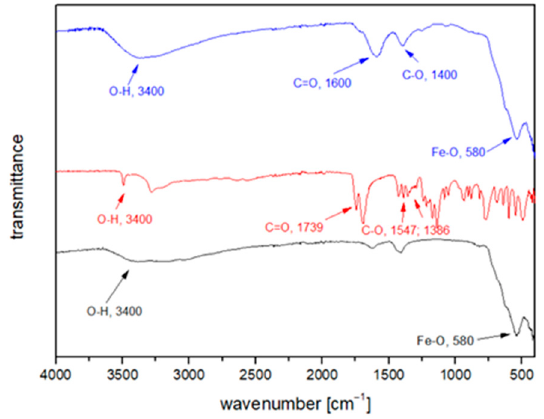
Figure 2. FTIR spectra of magnetite MNPs (black), CA (red), and Fe 3 O 4 @CA MNP’s (blue).